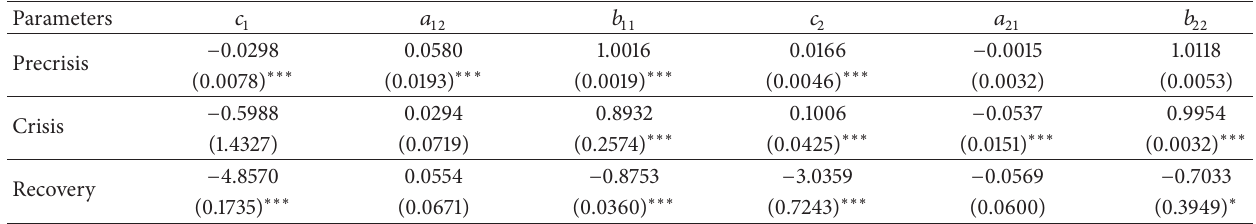
Table 3: Financial contagion analysis between the US and China.